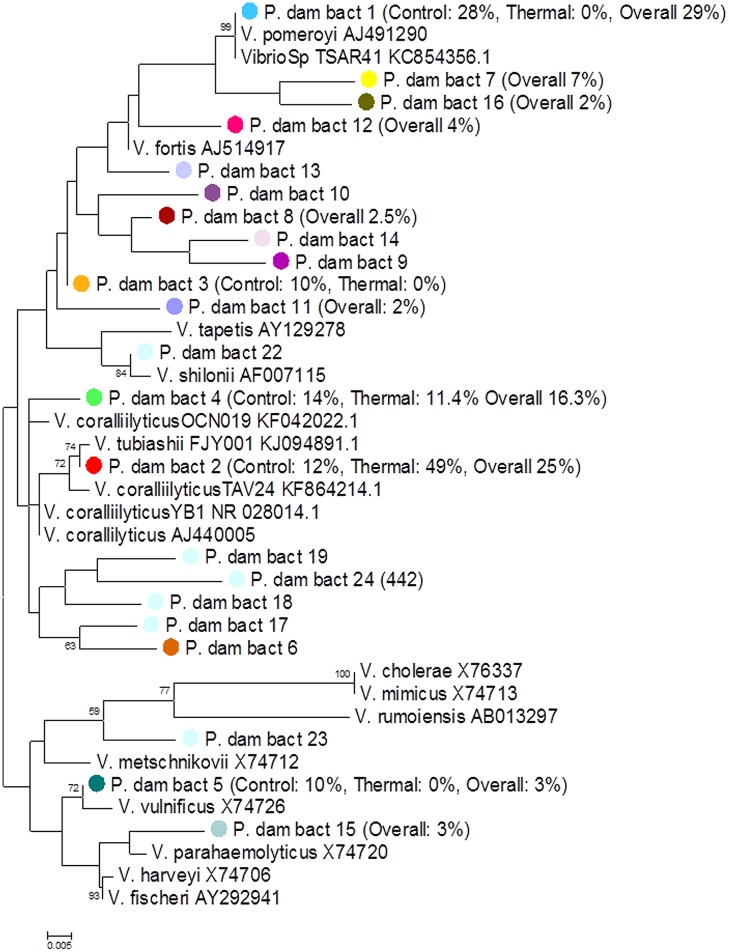
Phylogenetic tree of the Vibrio community associated with the coral P. damicornis. The colors of OTU circles match the color of OTUs from Figure 4. The percentage abundances of the OTUs in the tfinal Control and tfinal Heat Stress treatments are represented as a percentage of the total community composition only if the OTU is responsible for driving significant differences between the treatments according to SIMPER analysis (Supplementary Table S6). The numbers at the nodes are percentages indicating the levels of bootstrap support, based on 1,000 resampled data sets where only bootstrap values of >50% are shown. The scale bar represents 0.005 substitutions per nucleotide position.